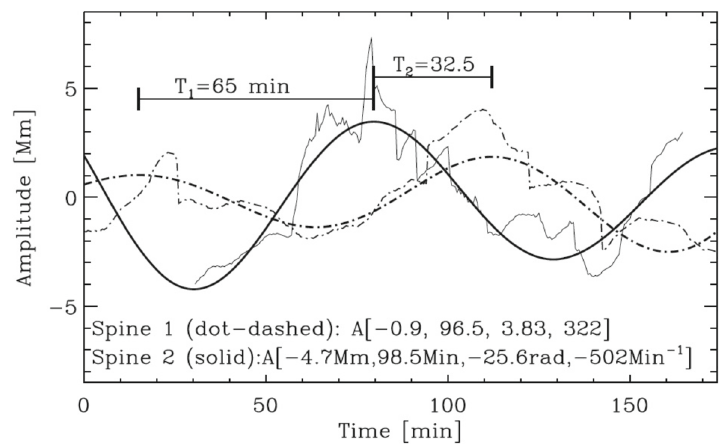
Fig. 14 Displacement of two spines of a quiescent prominence (thin lines) and best fits using the function A [ 0 ] sin ( 2 π t / A [ 1 ] + A [ 2 ] ) exp ( A [ 3 ] t ) (thick lines). The fitted values of the parameters A [ 0 ] to A [ 3 ] are writtenatthebottomofthefigure.Notethatthevaluesof A [ 3 ]